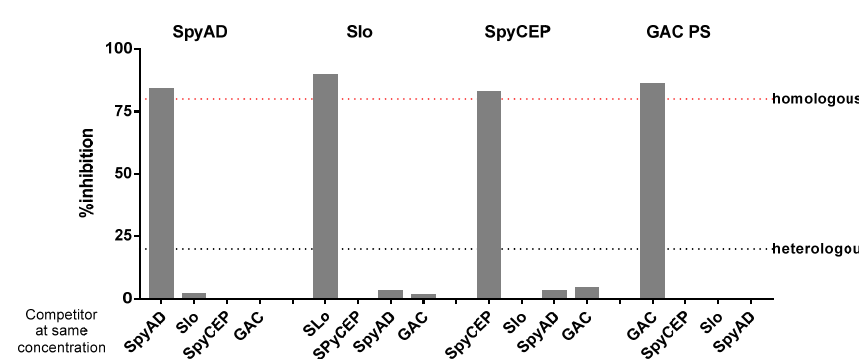
Figure 1. Assay specificity. ( A ) Percentage inhibition of MFI for each antigen after incubation with its homologous inhibitor at varying concentrations (in orange highlighted the lowest concentration of homologous competitor leading to >80% inhibition). ( B ) Percentage inhibition of homologous and heterologous 4-plex antigens at concentration of inhibitor which led to >80% inhibition of its homologous antigen in 1A. The figure depicts a single specificity experiment with a single batch of purified protein and group A Carbohydrate antigens. Percentage inhibition calculated from the average of two repeats of each antigen at each concentration.